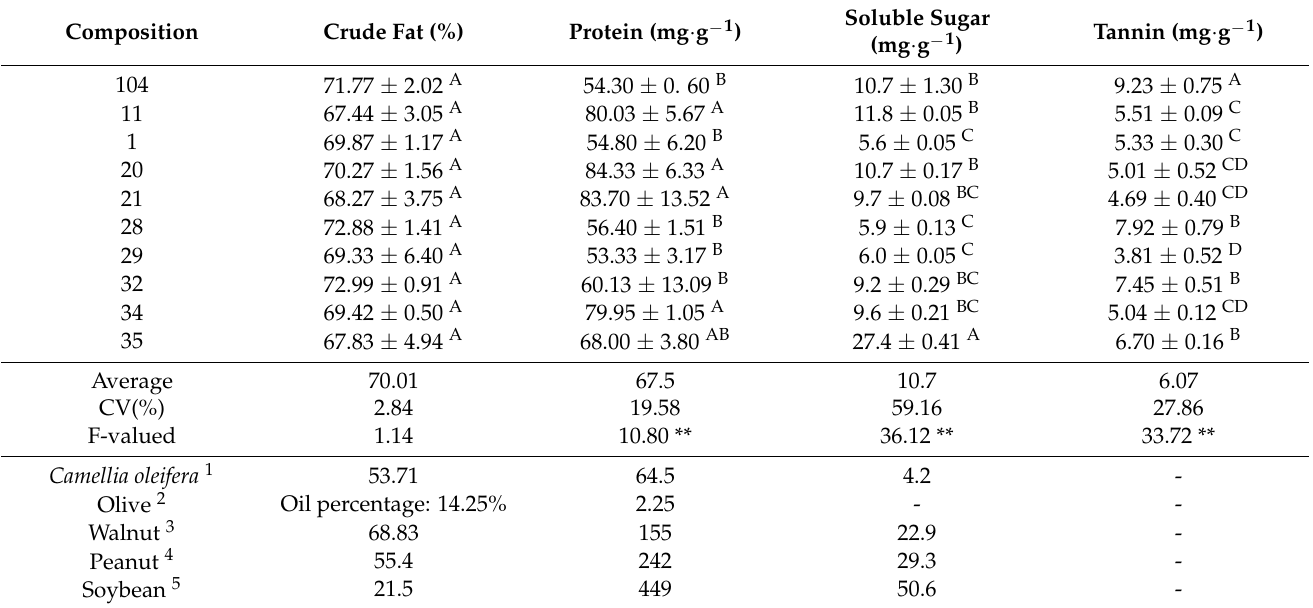
Table 2. Nutritional composition and content of kernels of 10 pecan varieties and some common oil